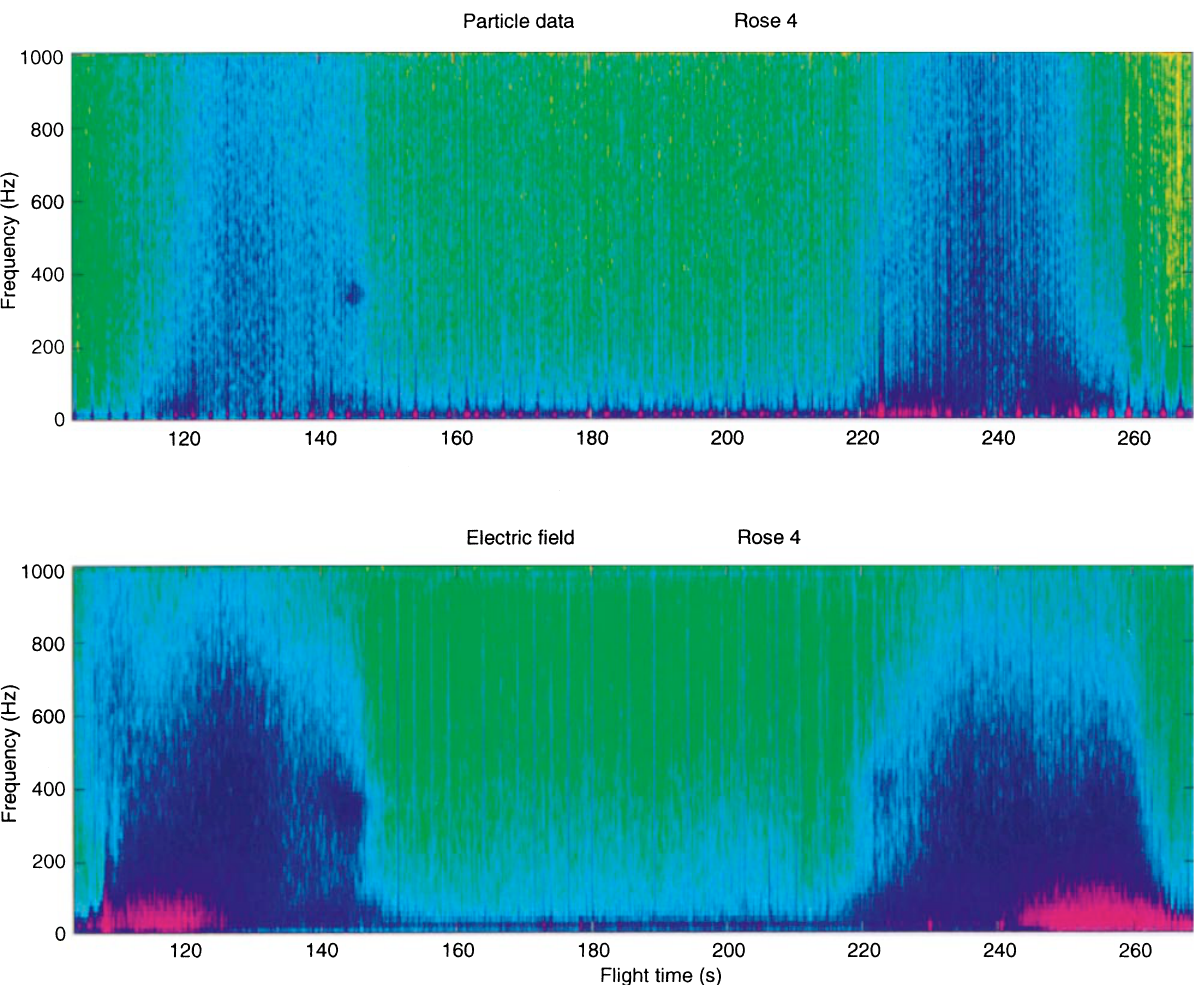
by the signal from one probe pair as in Fig. 4. The fluctuations at a frequency close to 400 Hz occur at a well-localized altitude, and fall outside the scope of the present study. Power spectral intensities are in